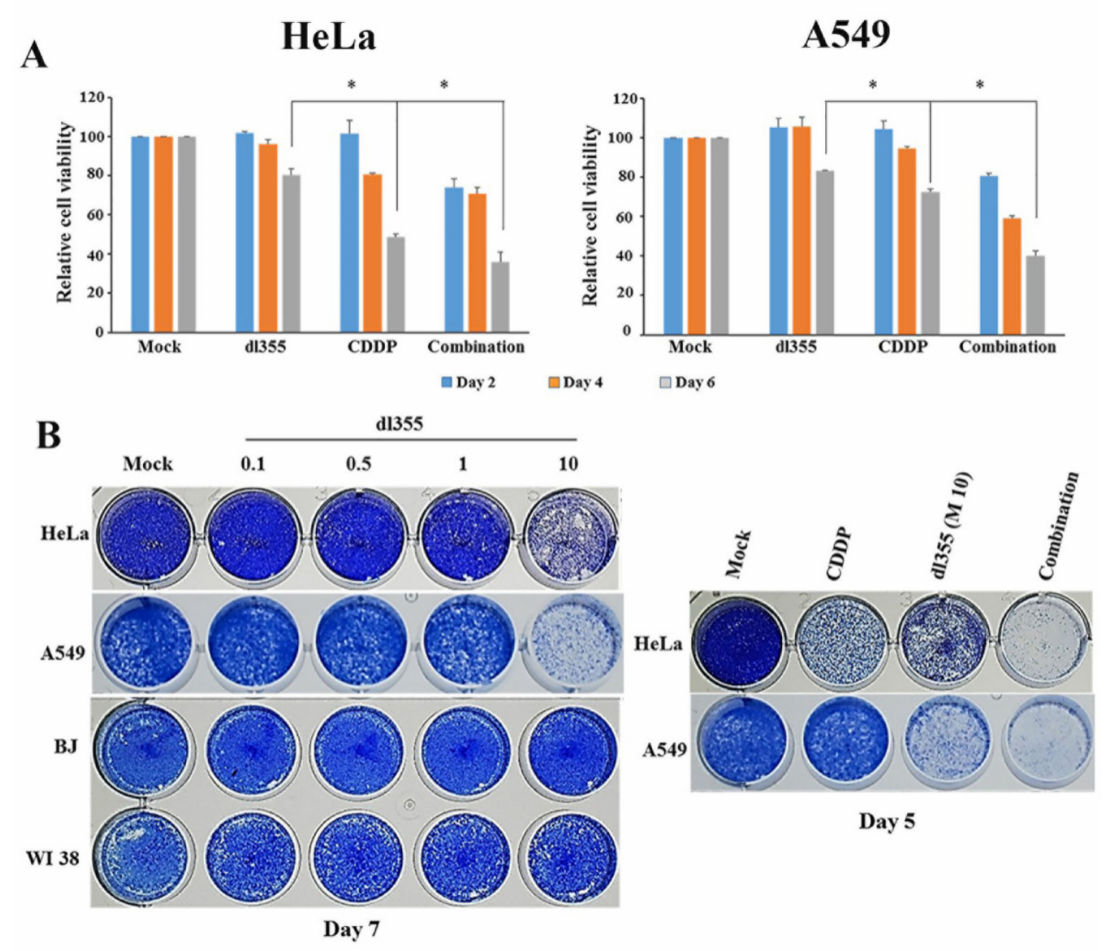
Figure 3. Cell viability assessment after dl355 infected and combination therapy. Cells were infected with dl355 at indicated MOIs (0.1, 0.5, 1, 10; vp / cell) or treated with CDDP (1.25 µ g / mL) or combination (CDDP 1.25 µ g / mL plus dl355 MOI 10; vp / cell) therapy. For combination therapy, cells were treated with CDDP for 4 h before infection with the virus. ( A ) At 2, 4, and 6 days of post-infection, cell viability was calculated by the XTT assay. ( B ) At 5 and 7 days of post-treatment, coomassie brilliant blue staining was used to evaluate the cytopathic e ff ect. The result shown is from a single experiment representative of two similar experiments. * indicates p <